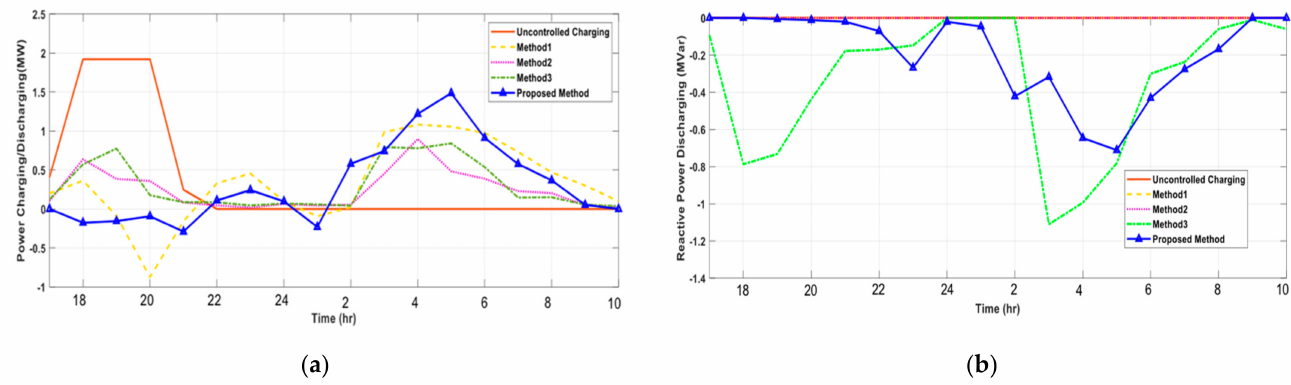
Figure 19. Schedule of ( a ) active power for EVs using different methods for weekend electric load profiles and ( b ) reactive power for EVs under different methods for weekend electric load